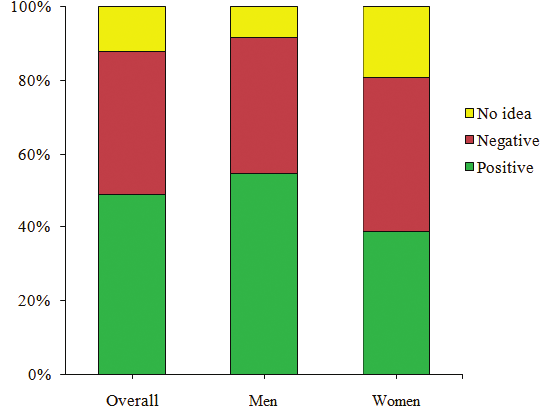
Figure A2. Responses to K3: “Nuclear power can contribute to sustainable economic development in Bangladesh”, K5: “Ban - gladesh should have skilled manpower development program and keep them up to the entire lifetime (60 years) of the Rooppur Nuclear Power Plant”.